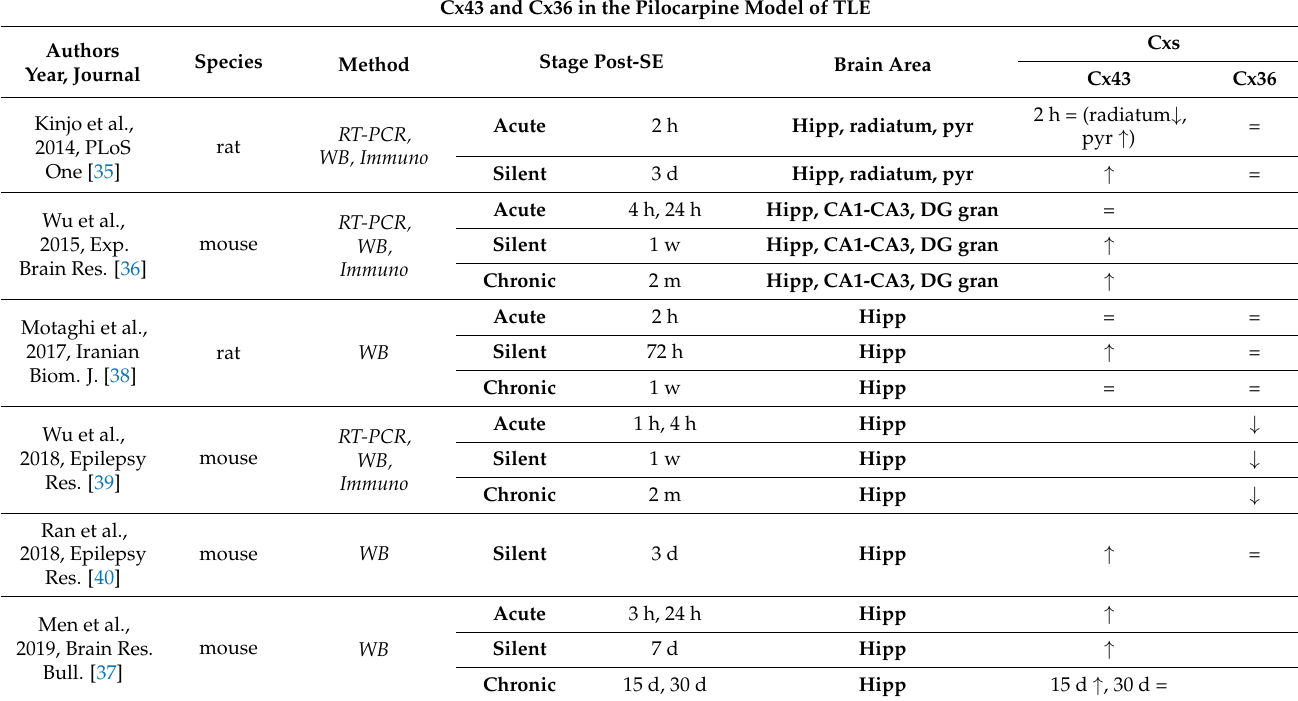
Table 1. Cx43 and Cx36 in the pilocarpine model of